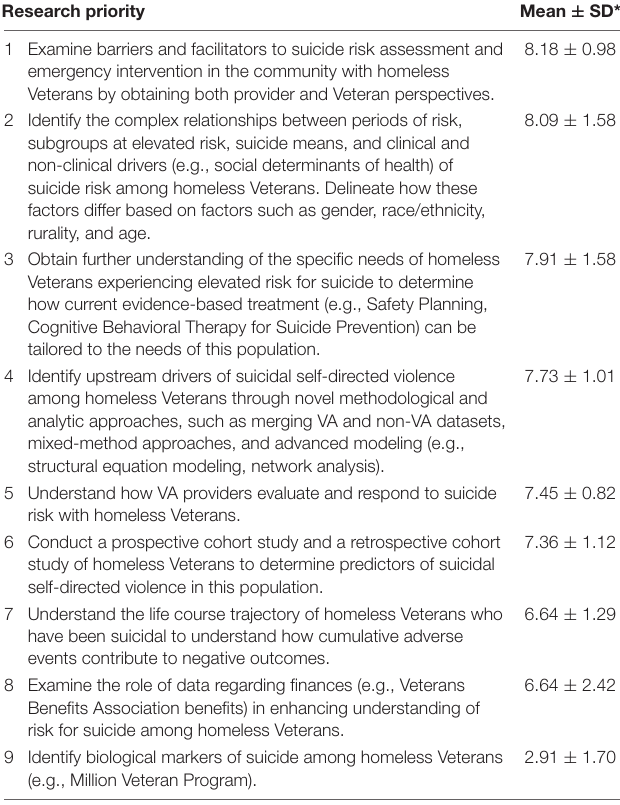
TABLE 1 | Agenda for research on suicide prevention among veterans experiencing